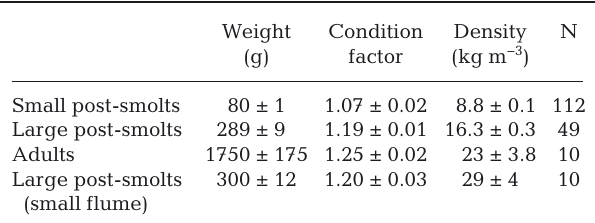
Table 1. Weight, condition factor, stocking density in the swim tunnel and the total number of Atlantic salmon tested in each group (N). Data are mean ±